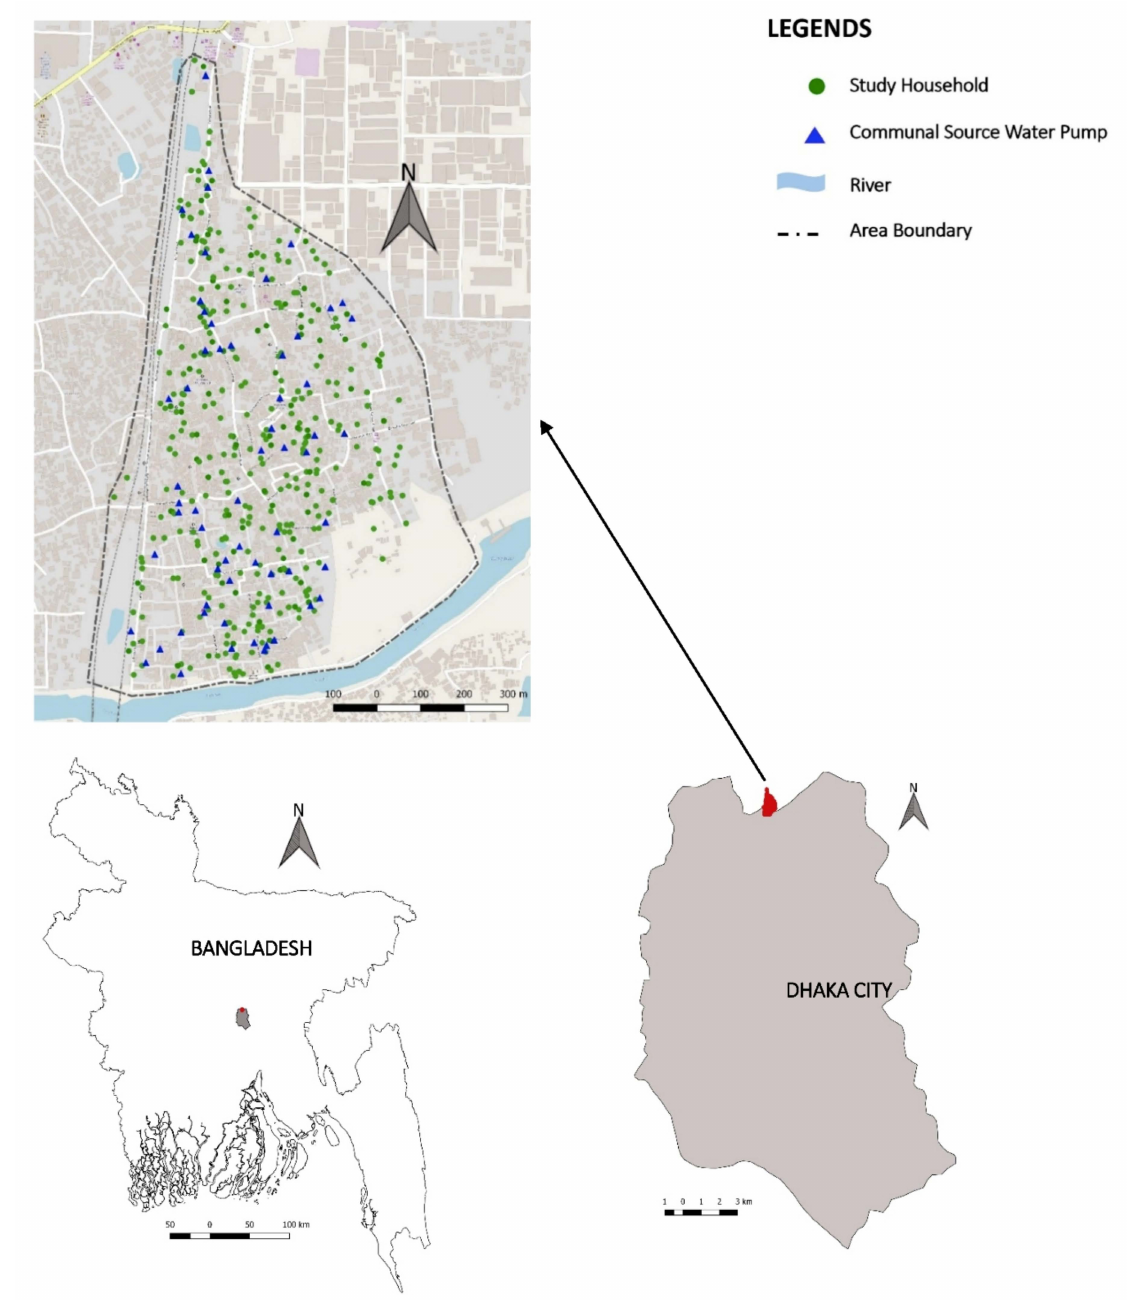
Figure 1. Map of the study area. The distribution of study households and communal source water pumps in the Arichpur